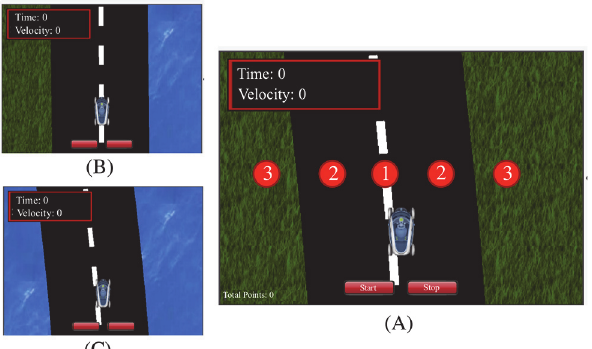
Fig 2. iPad application screen view. The subjects pressed the red start button to begin each trial (and were asked to not press the stop button during any trial). The time and velocity of the car was provided in the upper left hand corner of the screen. The three regions of speed are labeled in the figure with circles. Region 1 produced acceleration to maximum speed of 1100 pixels/sec; region 2 decelerated the car to 550 pixels/sec; region 3 immediately stopped the car to 2 pixels/sec. Cost functions: (A) symmetric low-cost, (B) asymmetric, (C) symmetric high-cost.